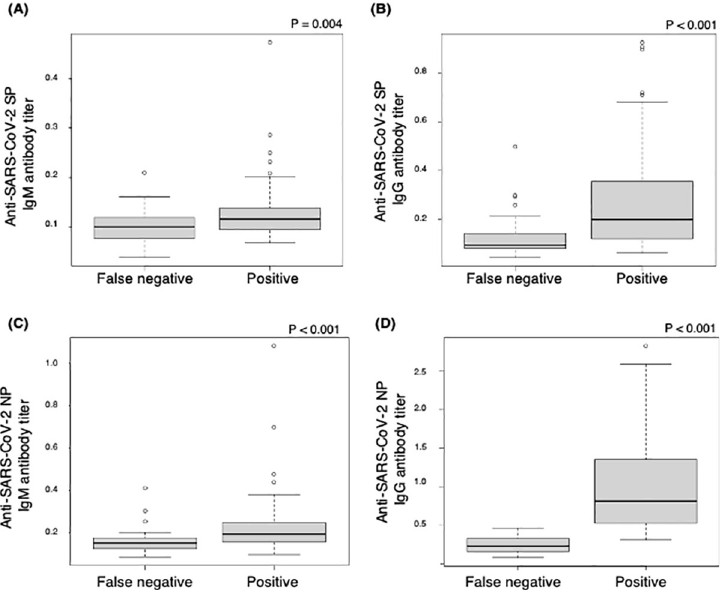
Fig 4. Comparison of anti-SARS-CoV-2 antibody titers between samples with false-negative and those with positive ECLIA results. SARS-CoV-2 SP IgM (A) and IgG (B) and SARS-CoV-2 NP IgM (C) and IgG (D) antibody titers in blood samples collected from 143 cruise ship crew members who had positive first SARS-CoV-2 genetic test results were measured using ELISA. Antibody titers were significantly lower in blood samples with false-negative ECLIA results (n = 31) than in those with positive ECLIA results (n = 112). SP, spike protein; NP, nucleocapsid protein; ELISA, enzyme-linked immunosorbent assay; ECLIA, electrochemiluminescence